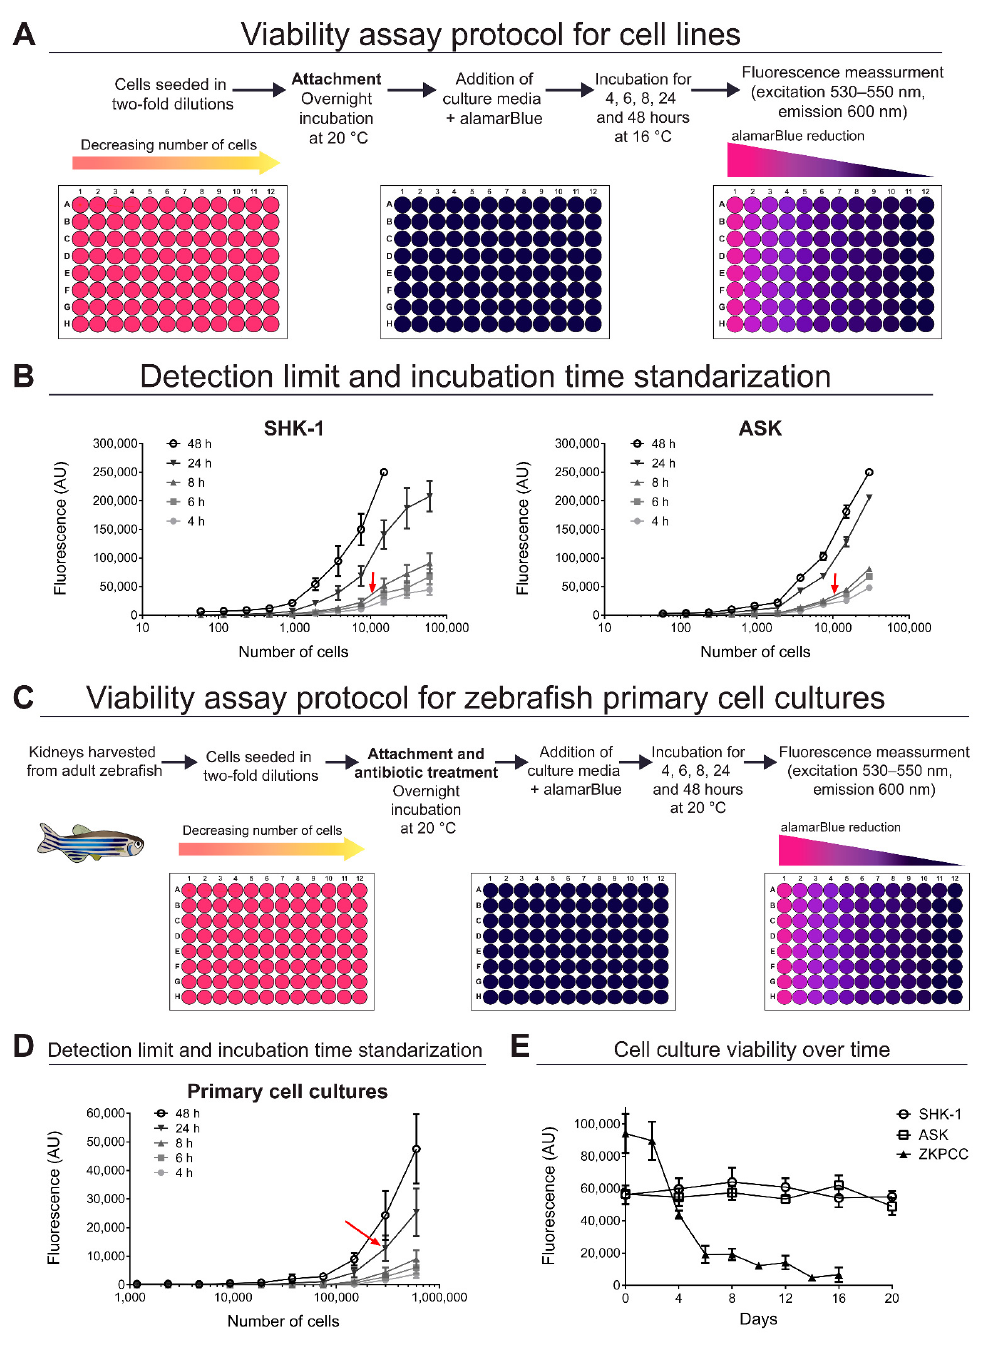
Figure 1. Standardization of cellular viability assays. Schematic representation of the protocol to monitor cell viability with alamarBlue in SHK-1 and ASK salmon cell lines ( A ), and for zebrafish kidney primary cell cultures (ZPCC) ( C ). Incubation with alamarBlue was carried out for 4, 6, 8, 24 and 48 h before fluorescence quantifications, at 16 ◦ C for the cell lines and 20 ◦ C for the ZKPCC. Fluorescence (in arbitrary units) emitted by different number of seeded cells is shown for the cell lines in ( B ) and ZKPCC in ( D ). Fluorescence was measured at 530–550 nm for excitation and 600 nm for emission. Red arrows indicate the number of cells and the incubation time chosen for subsequent experiments and correspond to 10,000 cells and 8 h of alamarBlue incubation for cell the lines, and 300,000 cells with 24 h of incubation for the zebrafish cultures (ZKPCC). The detection limit corresponds to the last fluorescence measurement different than zero; in the selected conditions, the detection limit was ~150 cells for SHK-1, ~250 cells for ASK and ~30,000 for the kidney primary culture cells. Viability of cells over time, measured as fluorescence emitted after reduction of alamarBlue in the selected conditions for each cell type, is shown for the three types of cultures in ( E